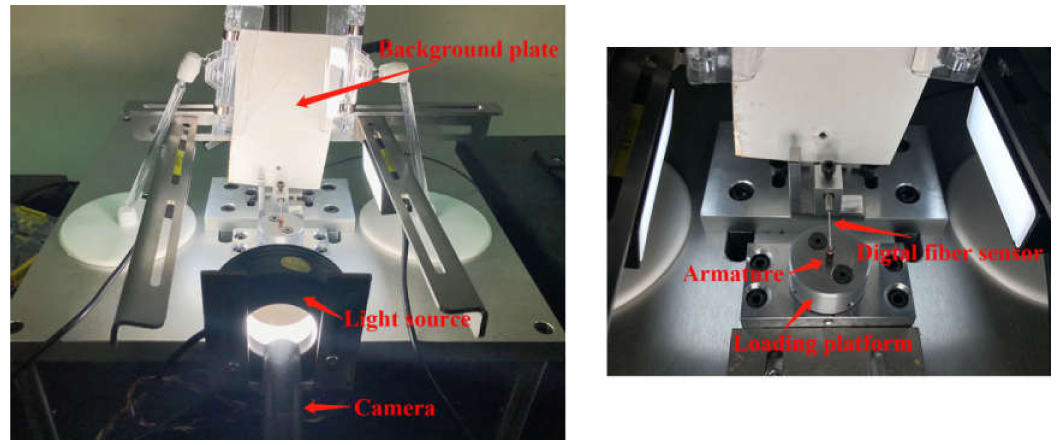
Figure 2. The positioning and imaging device.